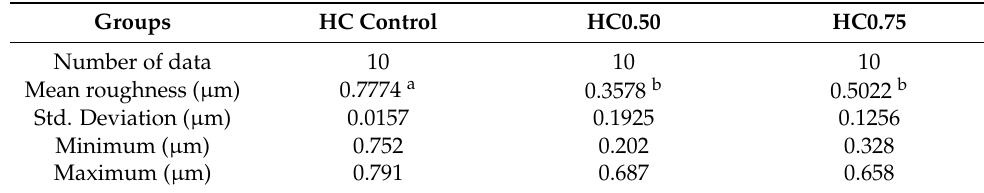
Table 3. Mean values of surface roughness in the HC acrylic resin incorporated with Ag-Zn zeolite at different percentages (0.50% and 0.75% w / w ) and without any Ag-Zn zeolite (control group). Different superscript letters represent significant statistical differences ( p < 0.05).